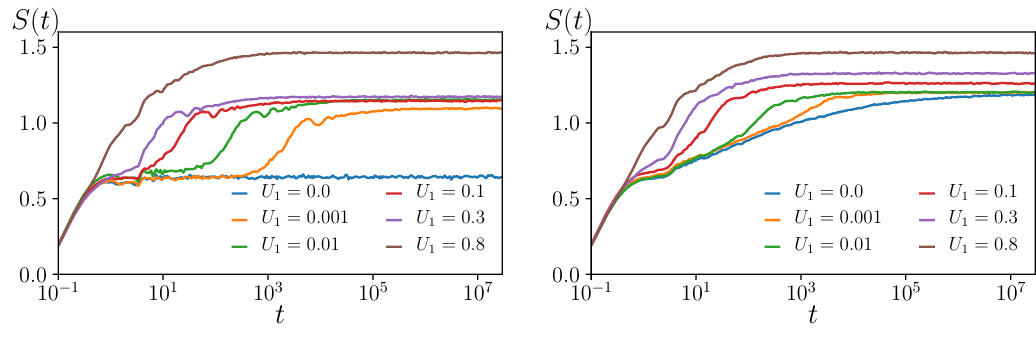
Figure 13: Contour plot of the average gap ratio r as a function of W and U average gap ratio is calculated at the center of spectrum ( ε = 0.5) for N = 8 bosons on K = 8 lattice sites. The on-site interaction strength is U = 1, the results are averaged over 160 disorder realizations.